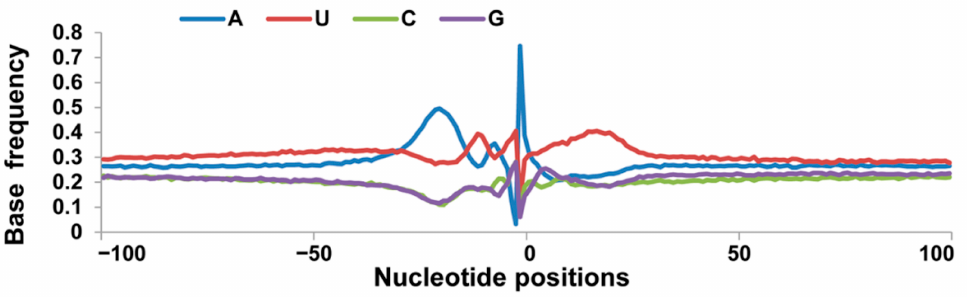
Figure 2. Distribution frequencies of A, C, G and U within 100 bp of the cleavage site of the poly(A) tail-containing transcripts of Sus scrofa . Single nucleotide profiles around the poly(A) sites. The Y -axis was used to plot the frequency of single nucleotides (A/U/G/C). Sequence upstream of the poly(A) site was from the − 100 to 0 region and sequence downstream of the poly(A) site was from 0 to +100. The CS is considered position